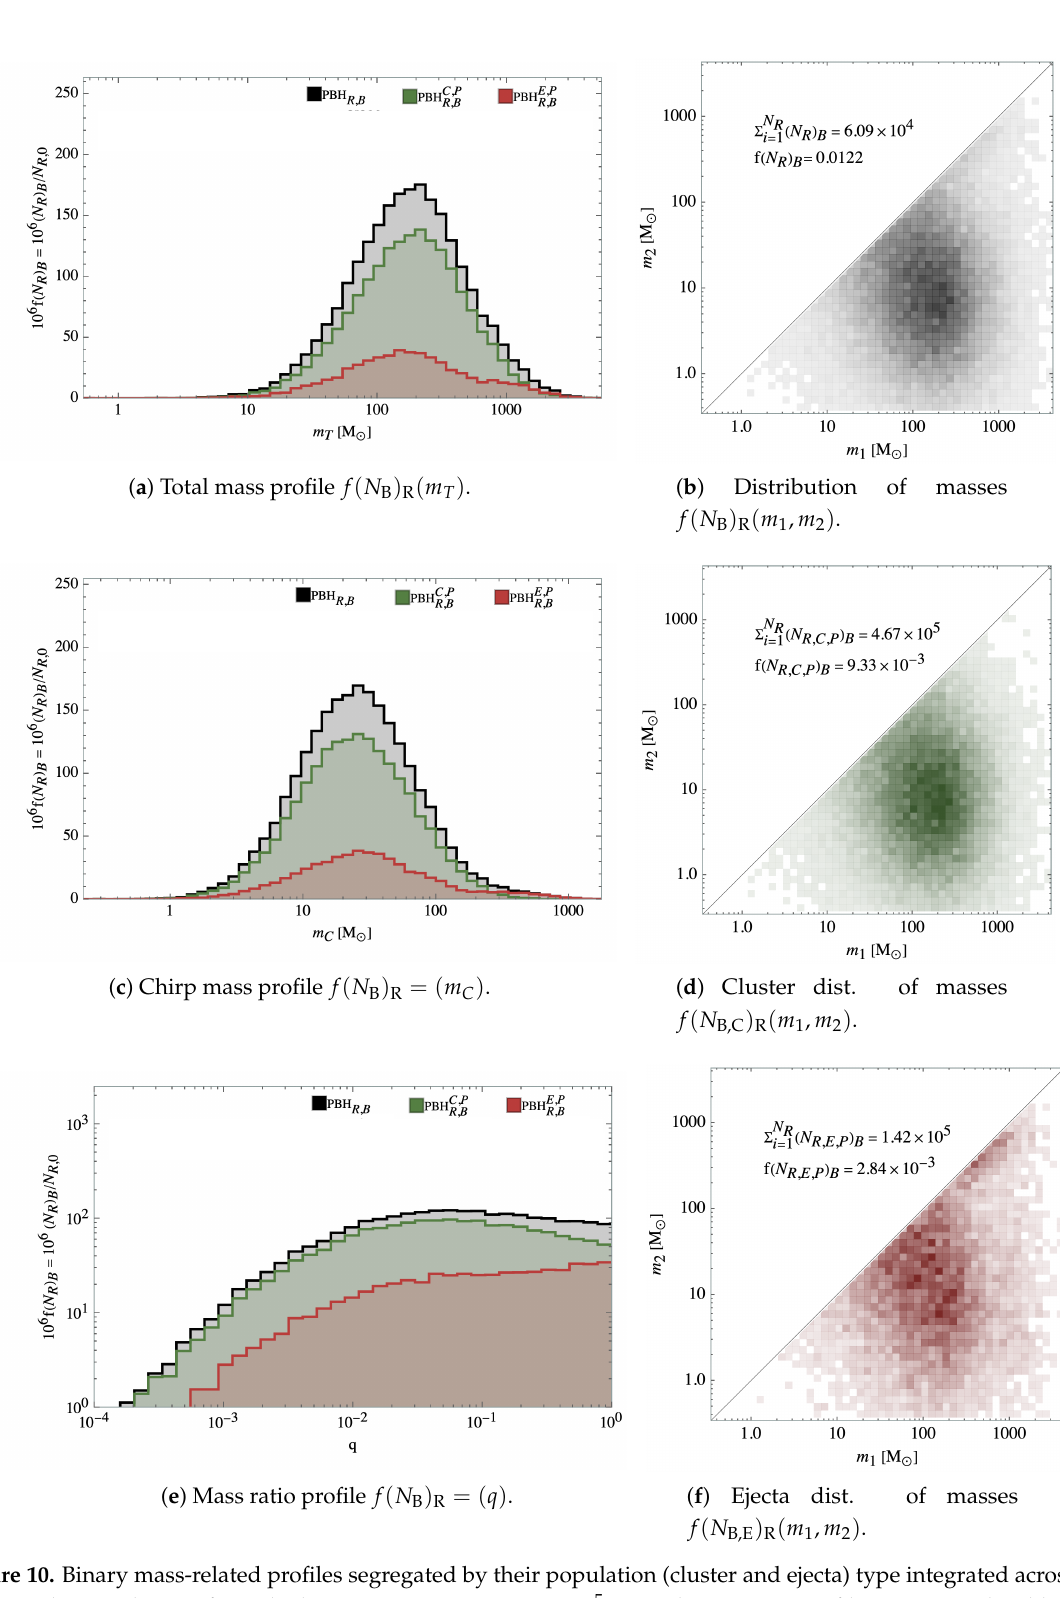
Figure 10. Binary mass-related profiles segregated by their population (cluster and ejecta) type integrated across all time slices in the simulations from the burn-in time, t BI = 2.64 × 10 5 yr, to the present. Profiles are normalised by the total number of objects in the simulations at the initial time, N t , and distribution mean and median values are given in Table 12. 0 Note that panels ( b , d , f ) are arranged by choosing m 1 > m 2 to avoid double-plotting, and therefore all binary systems are represented by a single point at or below the first quadrant